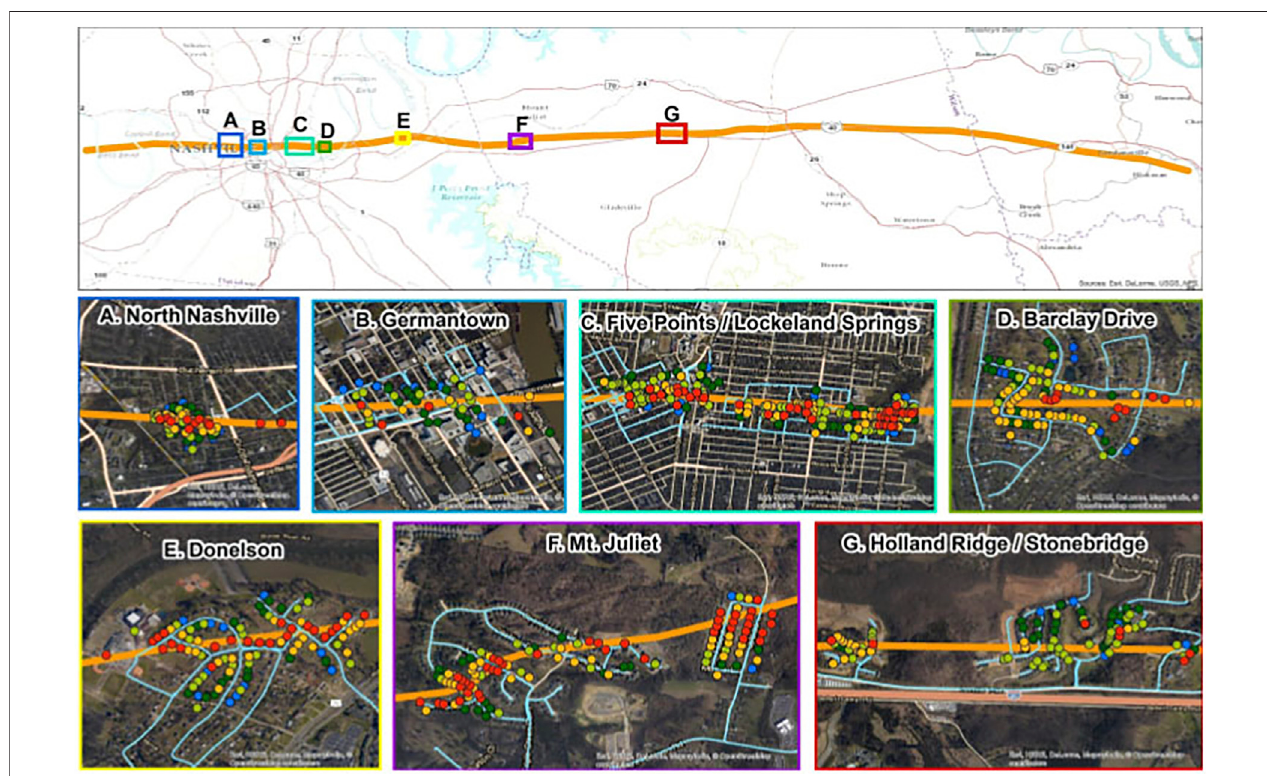
FIGURE 5 | StEER FAST app-based structural assessments in response to the Nashville tornadoes in key geographic regions relative to the tornado centerline. Blue lines in the detail plots indicate routes captured with street-level panoramas. Colored circles indicate locations of app-based structural assessments, where red to blue shading indicates high to low severity of